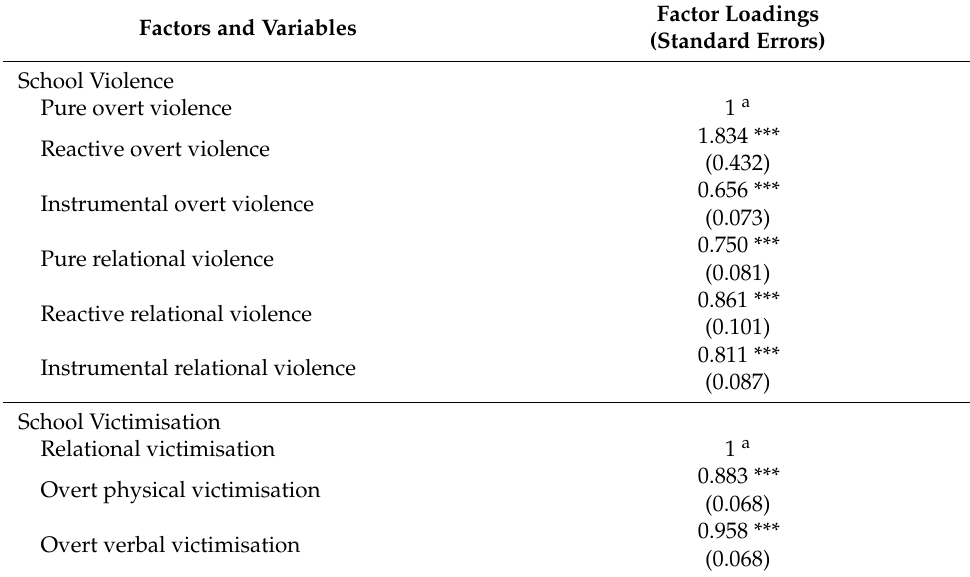
Table 3. Factorial loadings, standard error, and associated